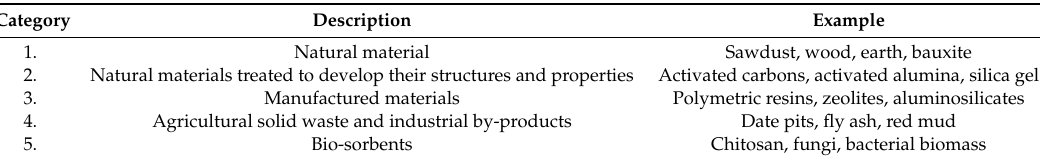
Table 1. Categorization of